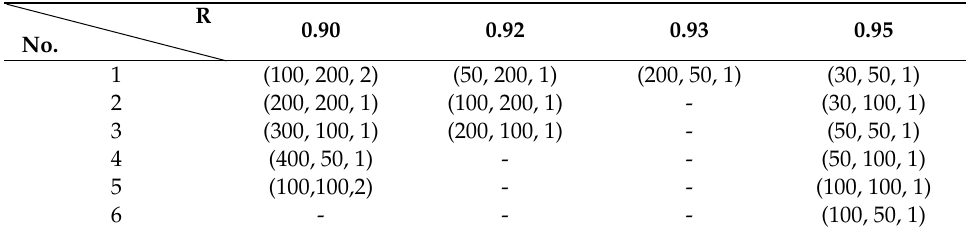
Table 1. Parameter combinations used in manipulating operation having R -value above 0.90 for all experimental data. ( ∆ x, ∆ y, n ) denotes the parameter values in the parameter combination.